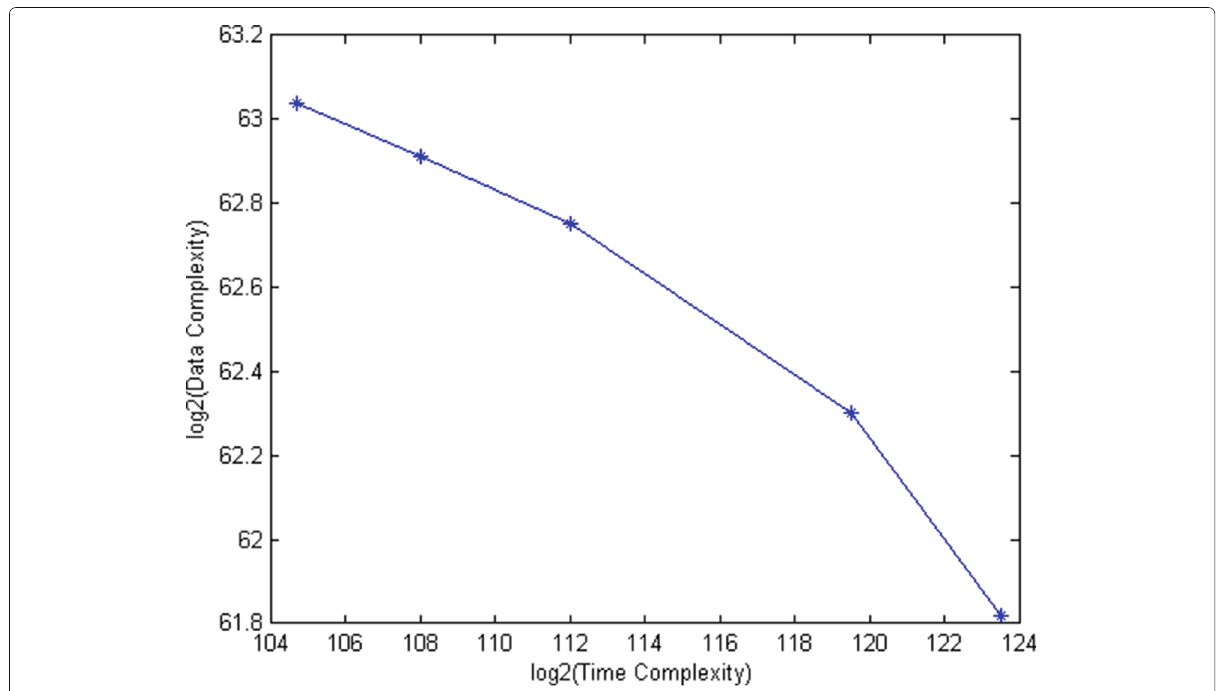
Fig. 4 Data-time tradeoff for the attack on 27-round TWINE-128